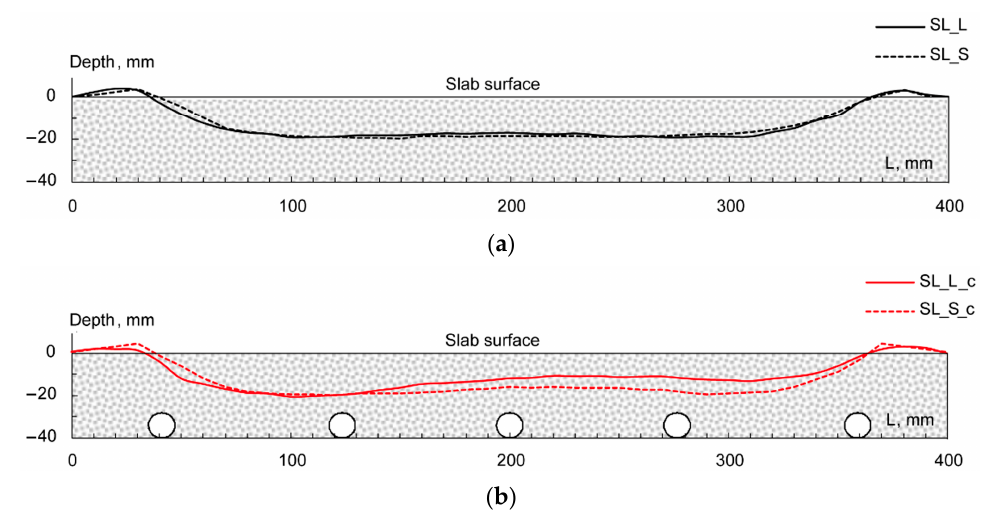
Figure 12. Rut profiles at 10,000 cycles for SL_L , SL_S ( a ) and SL_L_c , SL_S_c ( b ).